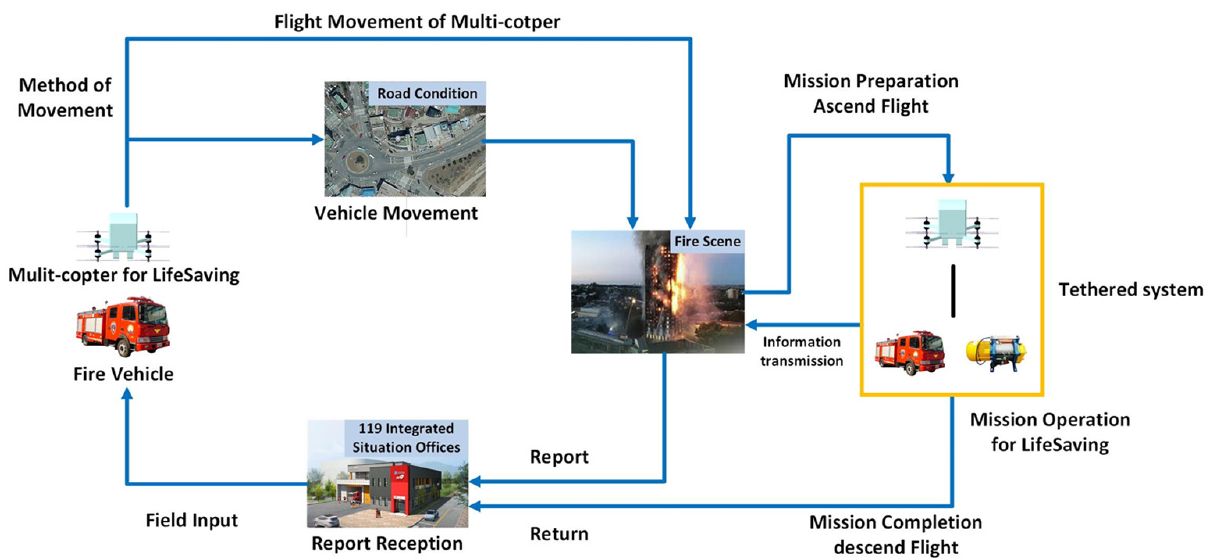
Figure 3. Mission profile of heavy-lift tethered multicopter for lifesaving mission.